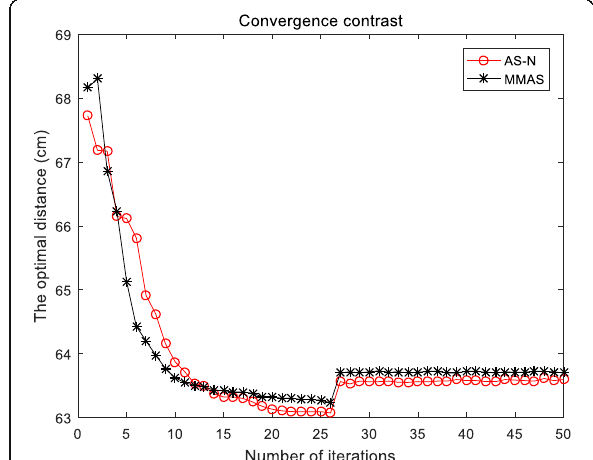
Fig. 8 Complex environment 1 box chart comparison